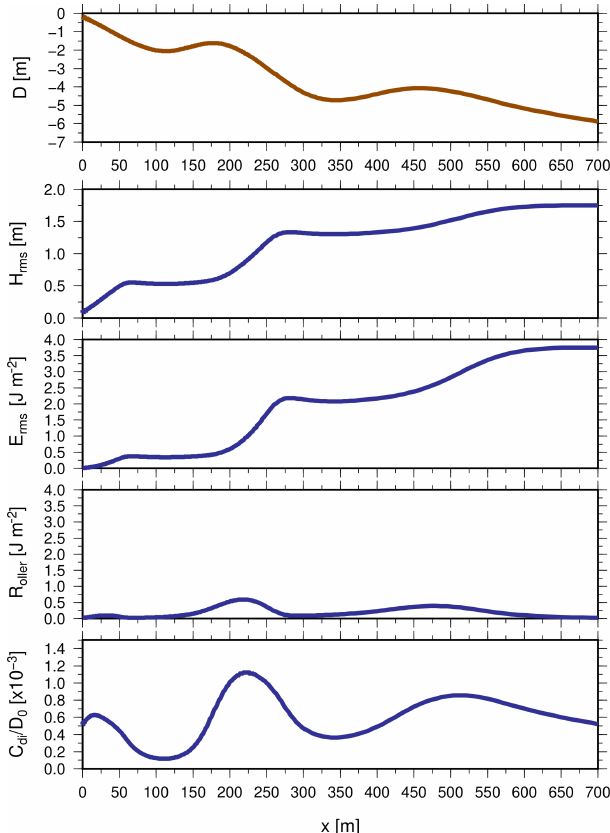
Figure 3. Basic state variables for a typical cross-shore beach pro- file (shoreline is at x = 0). From top to bottom: (a) water depth, (b) wave height, (c) wave energy, (d) roller energy and (e) depth- averaged sediment